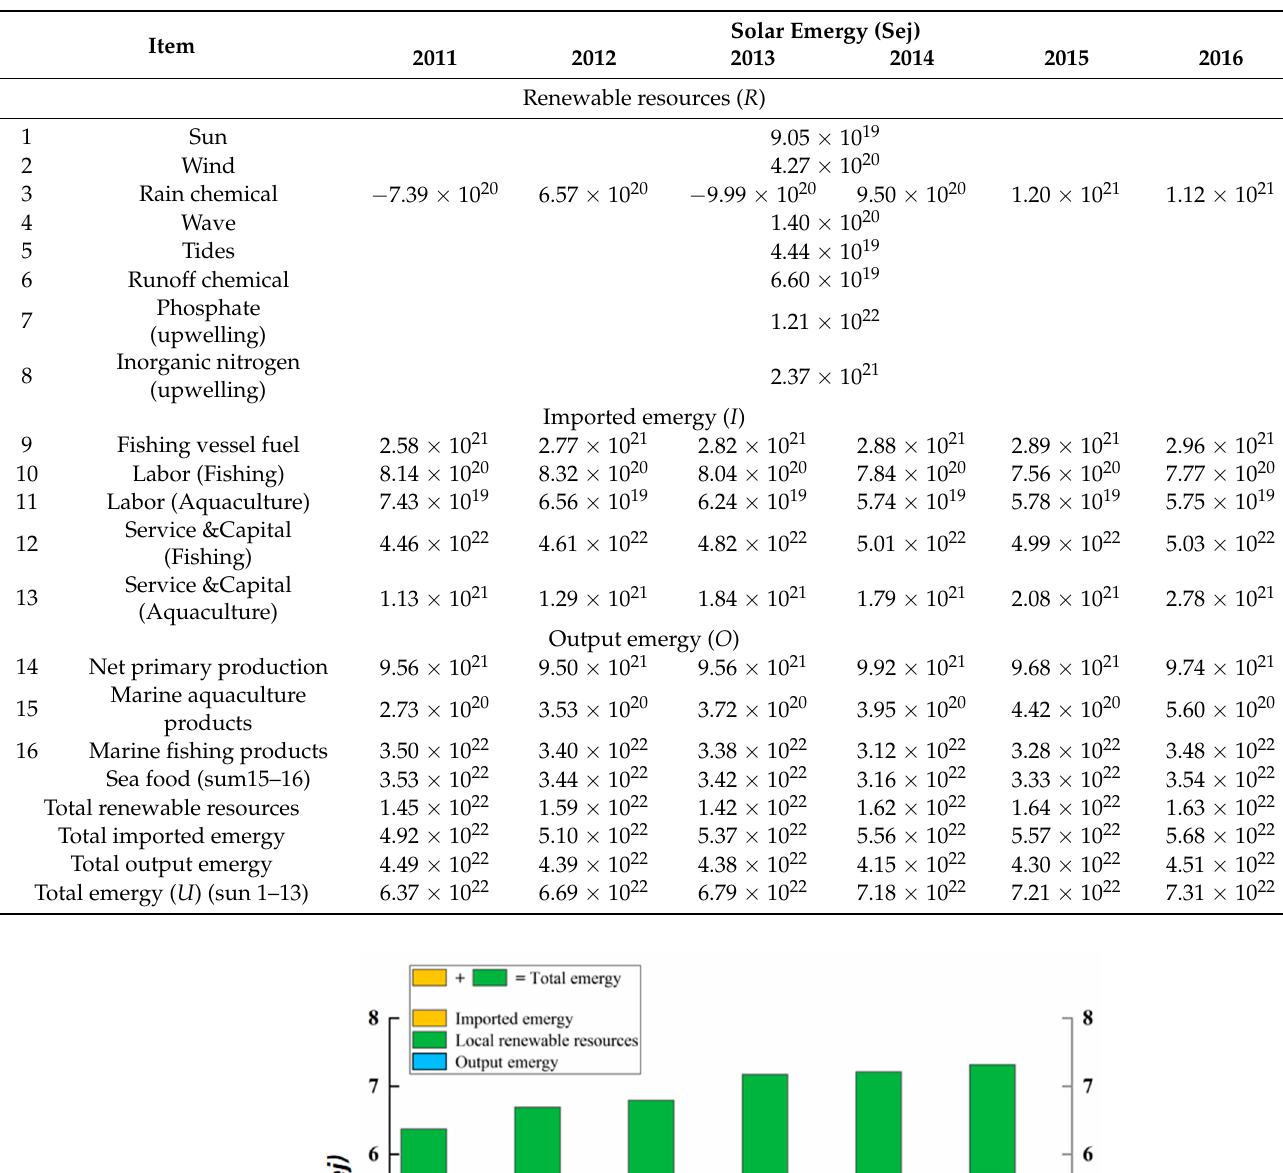
Table 3. The emergy evaluation of Zhoushan sea area during 2011~2016.